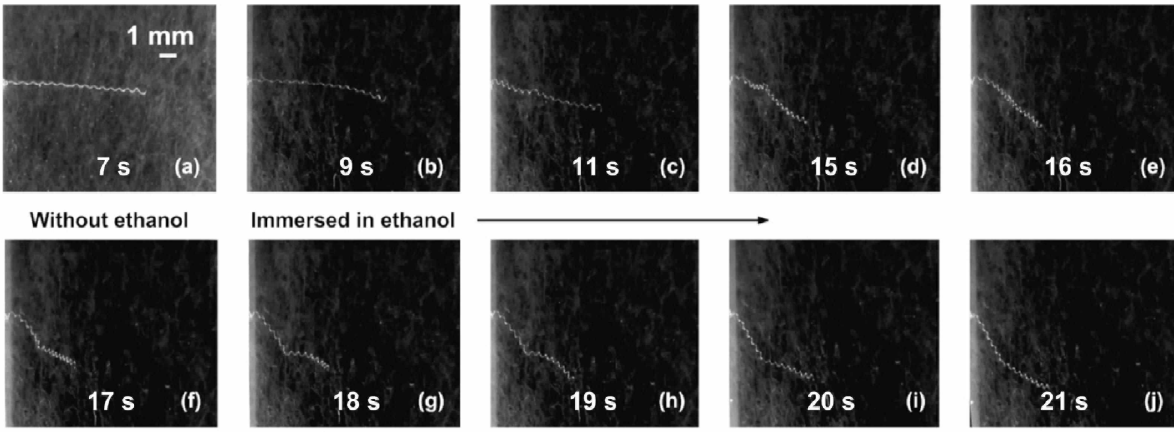
Figure 14. Morphing in a pre-stretched PU spring after immersing into room temperature ethanol. ( a ) No significant shape change in the first 7 s; ( b – f ) contraction for 8 s; and ( f – j ) expansion for 4 s. (Reproduced with permission from [102]. Copyright 2012